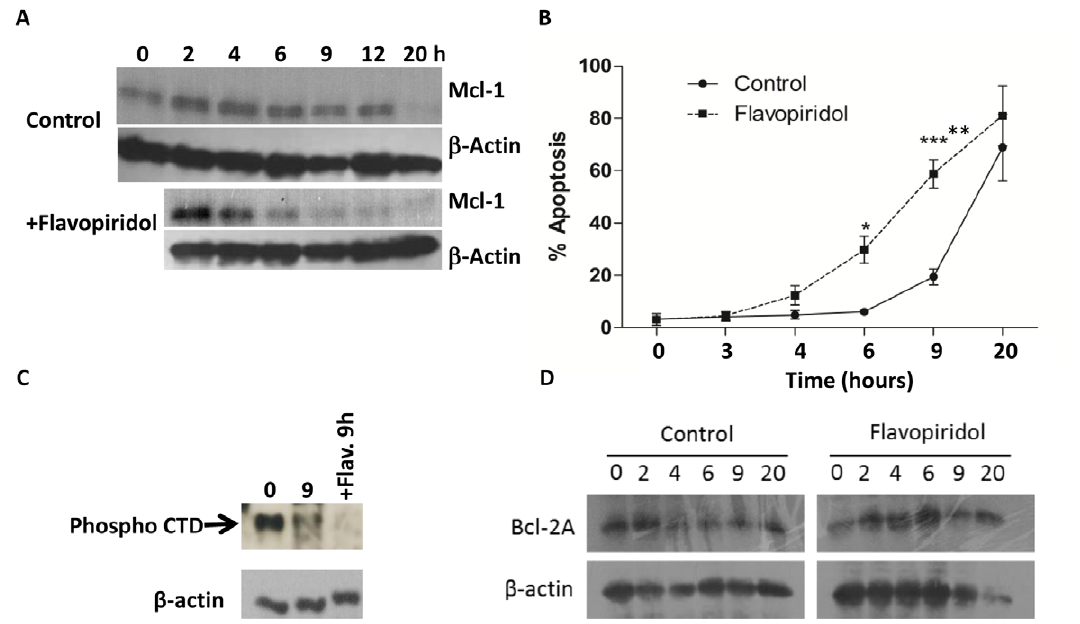
Figure 4. Flavopiridol treatment accelerates loss of Mcl-1. (a) Isolated human neutrophils were cultured in the absence (control) or presence of 100 nM flavopiridol for 0-20 h and Mcl-1 protein expression measured by western blotting. Blots were probed for b -actin to confirm equal loading. (b) In the same experiments neutrophil apoptosis was determined by measurement of DiOC 6 uptake. Data are expressed as the % of apoptotic cells in the control (solid line) and flavopiridol (broken line) treated cultures and are mean 6 s.d. for four separate experiments. * indicates p , 0.05 and ** indicates p , 0.01 for control versus flavopiridol treated cells. (c) CDK9 activity was measured in control, flavopiridol (100 nM) and flavopiridol plus GM-CSF (50 ng/ml) treated neutrophils by immunoprecipitating CDK9 from neutrophils with a monoclonal anti-CDK9 antibody and determining activity by assessing incorporation of [ c 32 P]-ATP into the CTD of RNA polymerase II. The phosphorylated peptide was isolated on an SDS-PAGE gel and visualised by autoradiography. The image shown is representative of 3 separate experiments performed. (d) Isolated human neutrophils were cultured in the absence (control) or presence of 100 nM flavopiridol for 0–20 h and Bcl2A protein expression measured by western blotting. Blots were probed for b -actin to confirm equal loading.